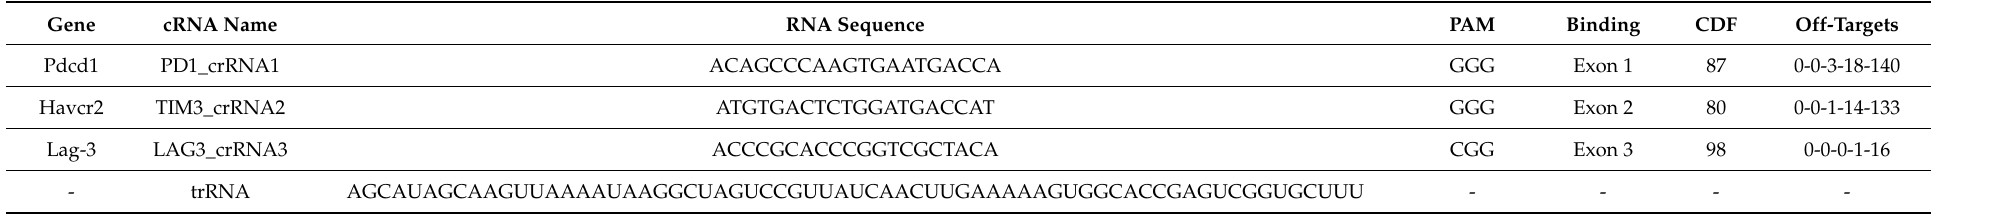
Table 1. List of crRNA used for CRISPR/Cas9 gene